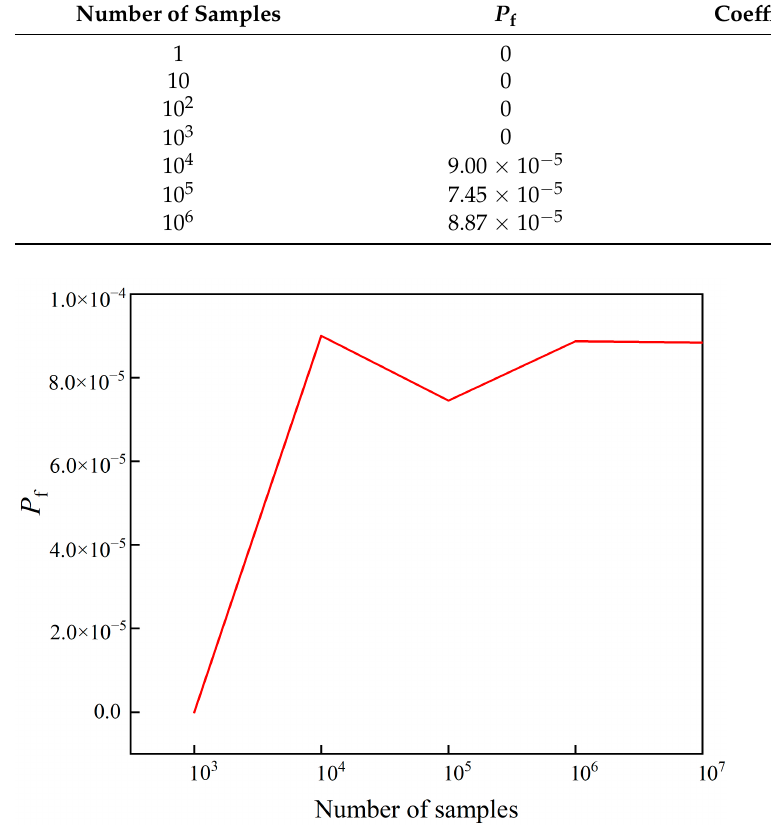
Figure 11. The curve of P f